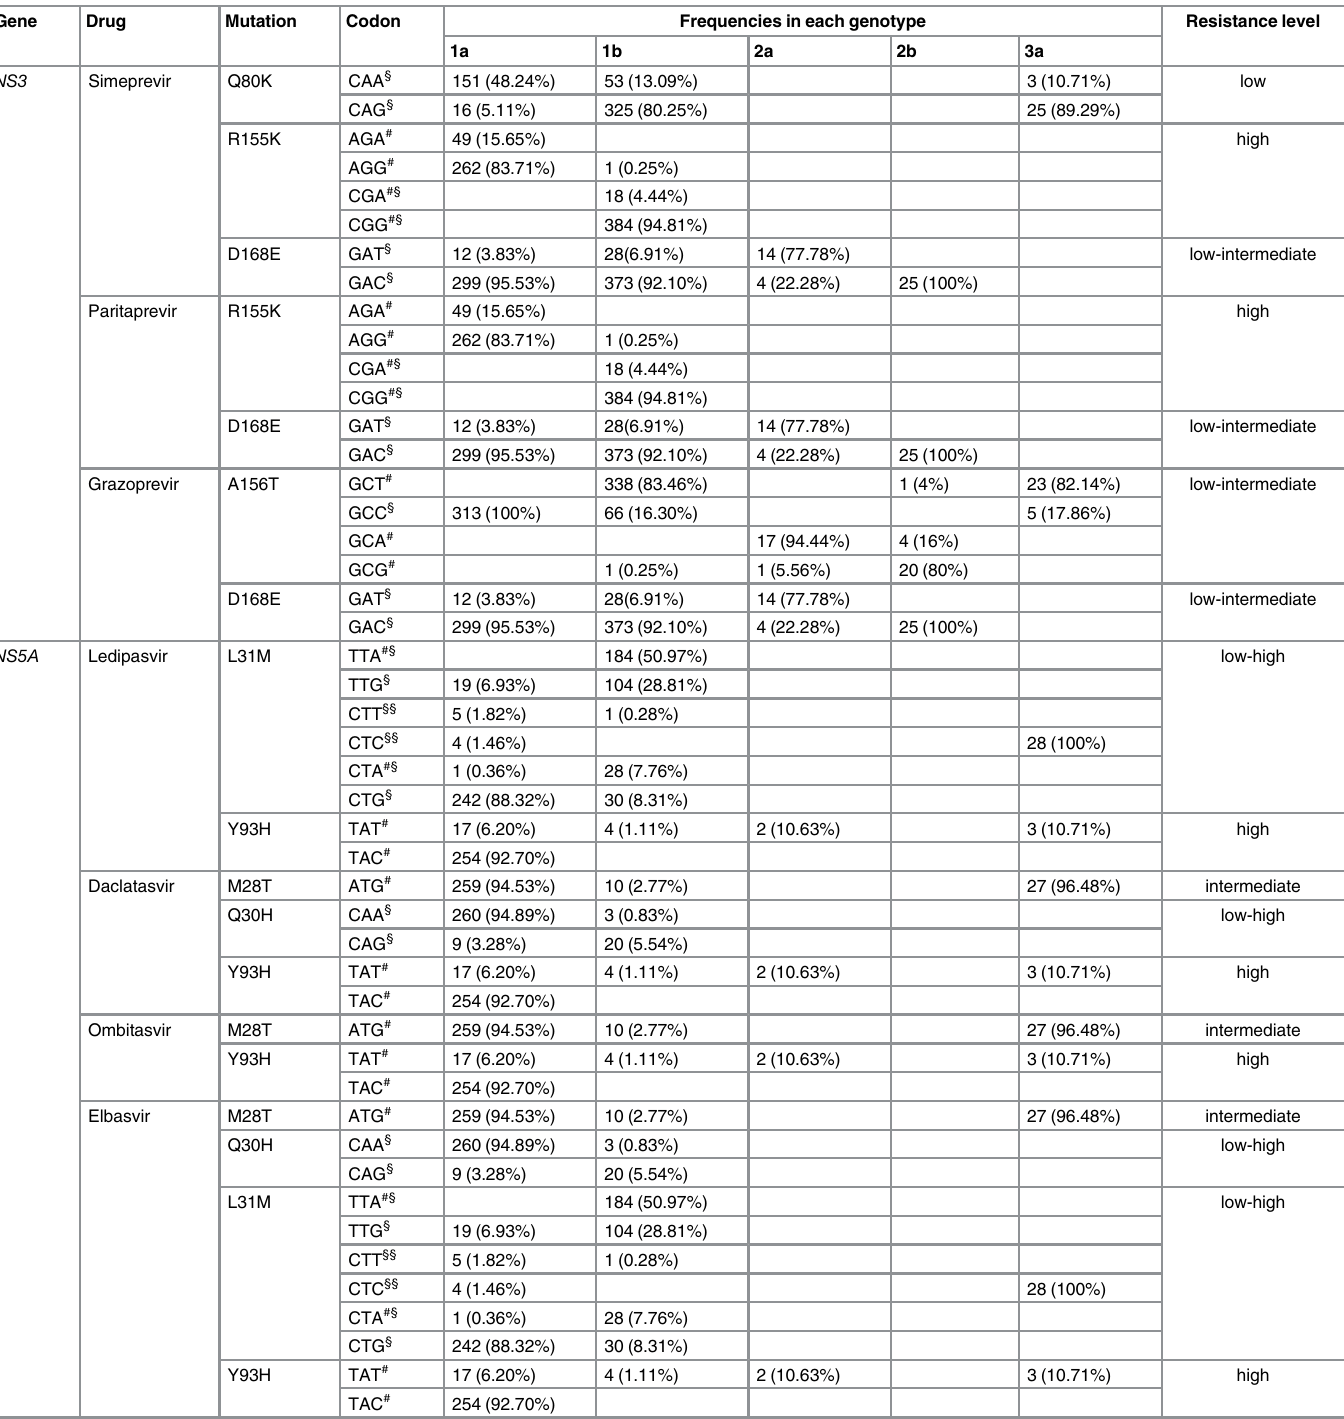
Table 4. Resistance level to DDA at HCV NS3, NS5A and NS5B positions and level of genetic barrier. Gene